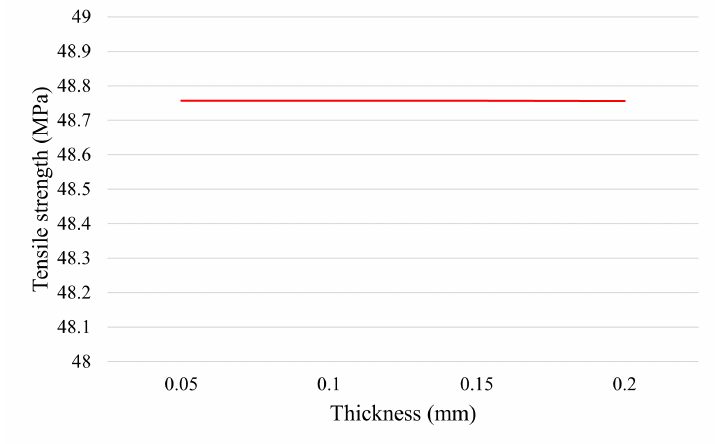
Figure A13. Graphs tensile strength vs. thickness generated from the algorithm.